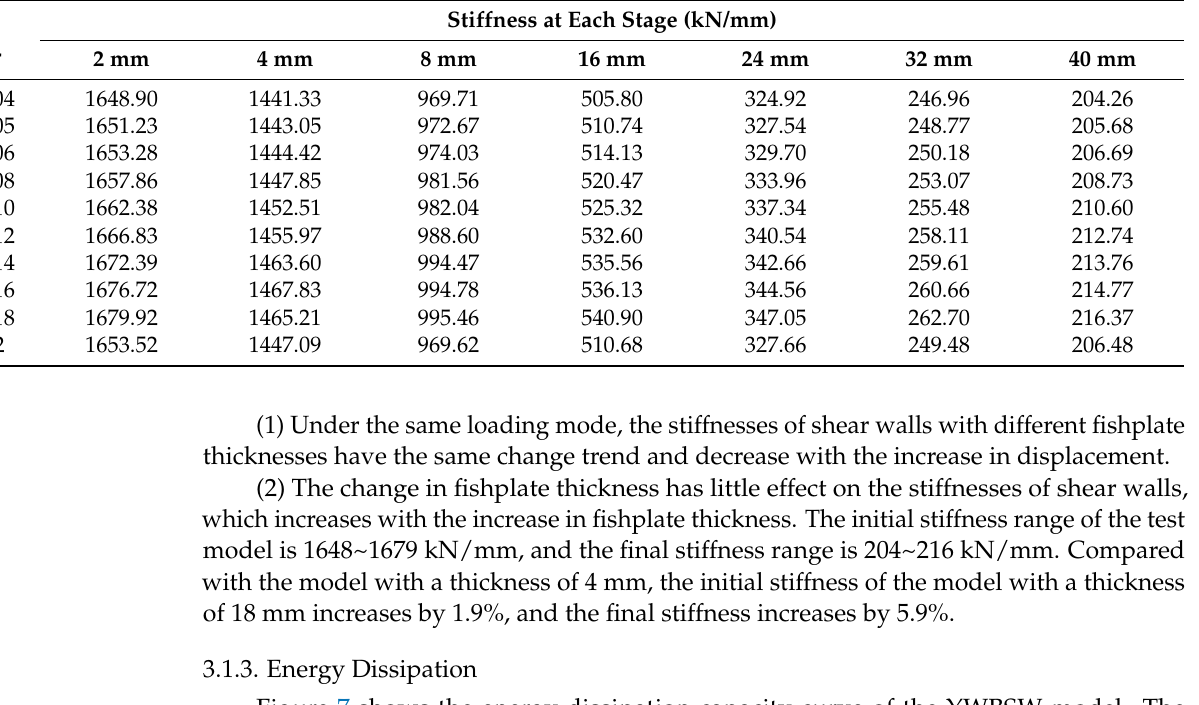
Table 5. Stiffness of models with different fishplate thicknesses.